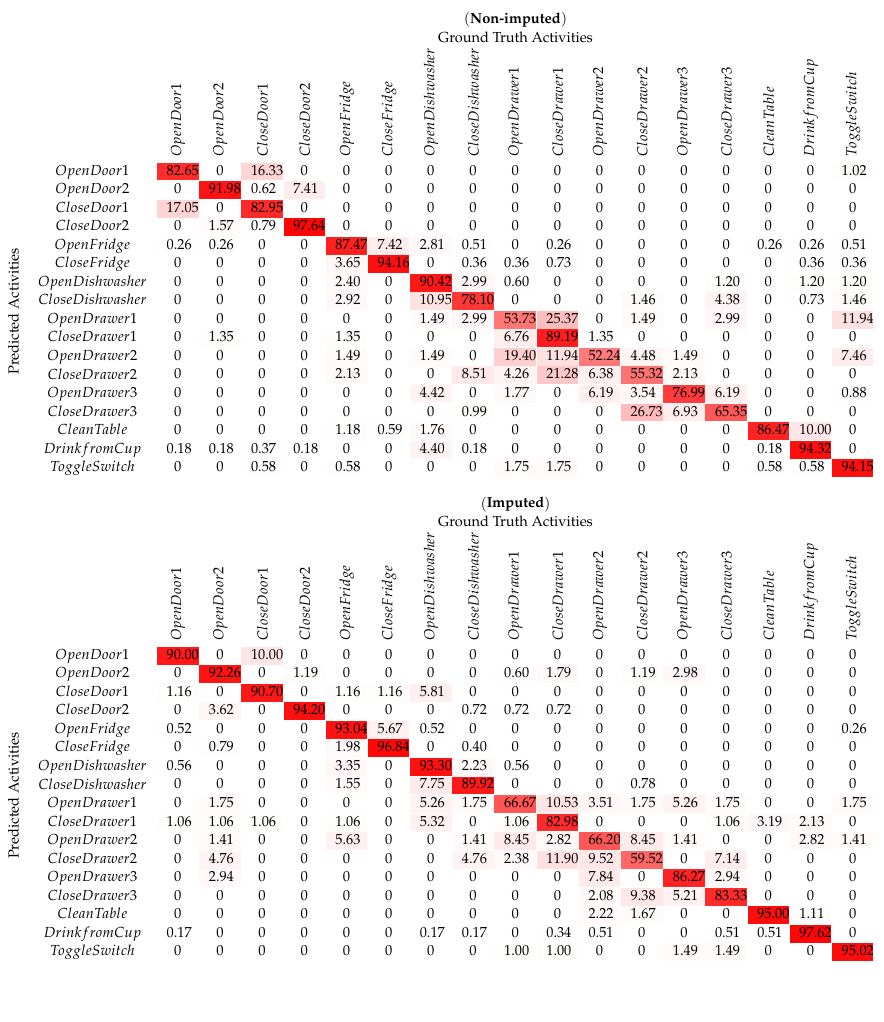
Table 3. Confusion matrix for per-class HAR using non-imputed & imputed Opportunity dataset.